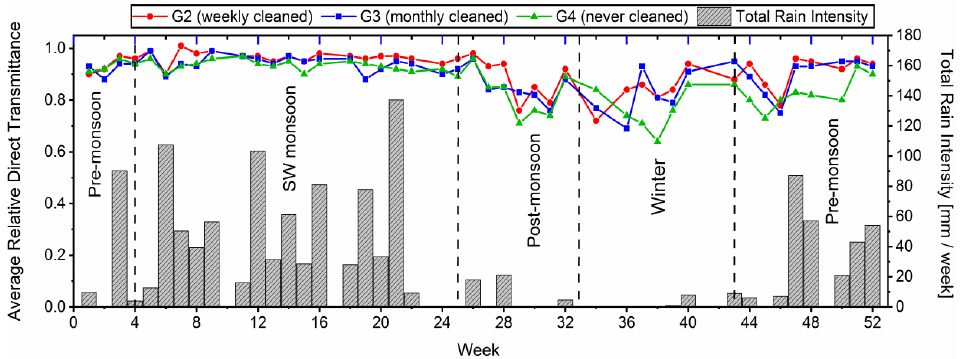
Figure 4. The average relative direct transmittance of glass coupons with different cleaning cycles (G2, G3, and G4) and total rainfall intensity (in mm/week) in consecutive weeks of the year.